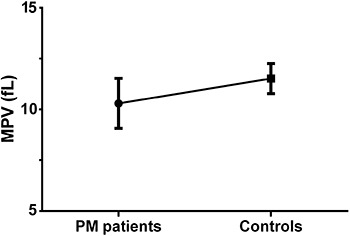
Mean platelet volume (MPV) in polymyositis (PM) patients and healthy controls.
P<0.001, Student's t-test.